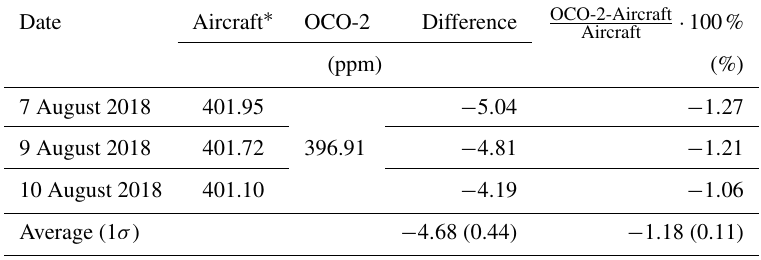
Table 2. X CO derived from aircraft on each observation day (7, 9 and 10 August) supplemented the aircraft profile by method (1). OCO-2 2 (V9r) X CO values were from 5 August, which was the closest time point of X CO 2 period. Differences between aircraft X CO and OCO-2 are shown in the fourth (ppm) and fifth (%) columns. The average difference and 2 standard deviation are shown in the fifth row.